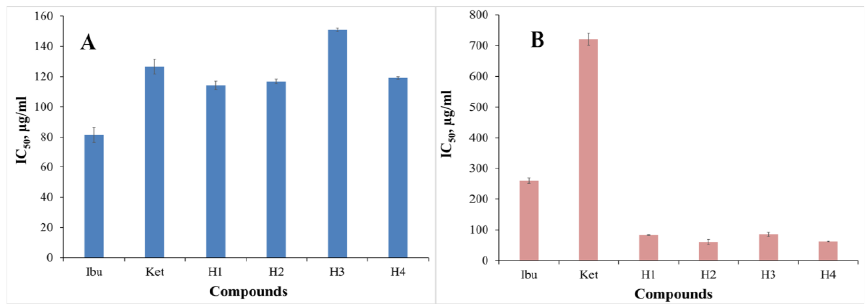
Figure 5. In vitro biological activity was assessed as inhibition of albumin denaturation (IAD) ( A ) and antitryptic activity (ATA) ( B ). As benchmarks, anti-inflammatory medications such as ibuprofen and ketoprofen were utilized. The results of both methods are presented as IC 50 .